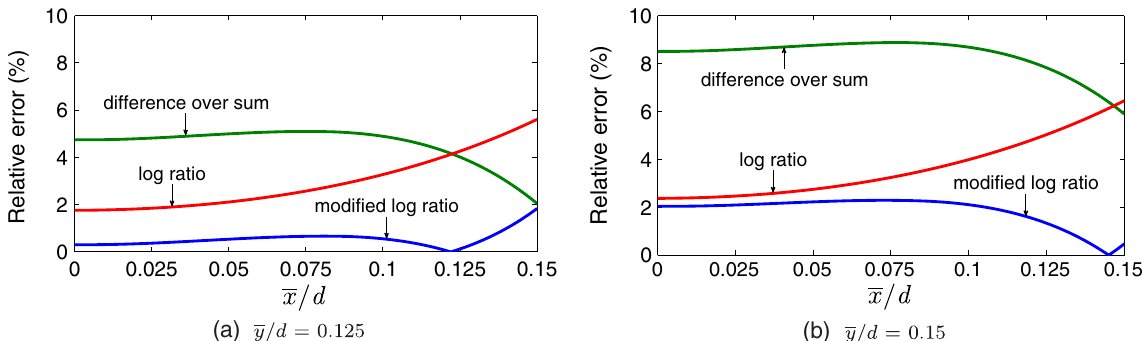
FIG. 9. ð σ 2 x − σ 2 y Þ =d 2 as a function of the beam position; c x ¼ 0 . 1735 , c y ¼ 0 . 1885 .